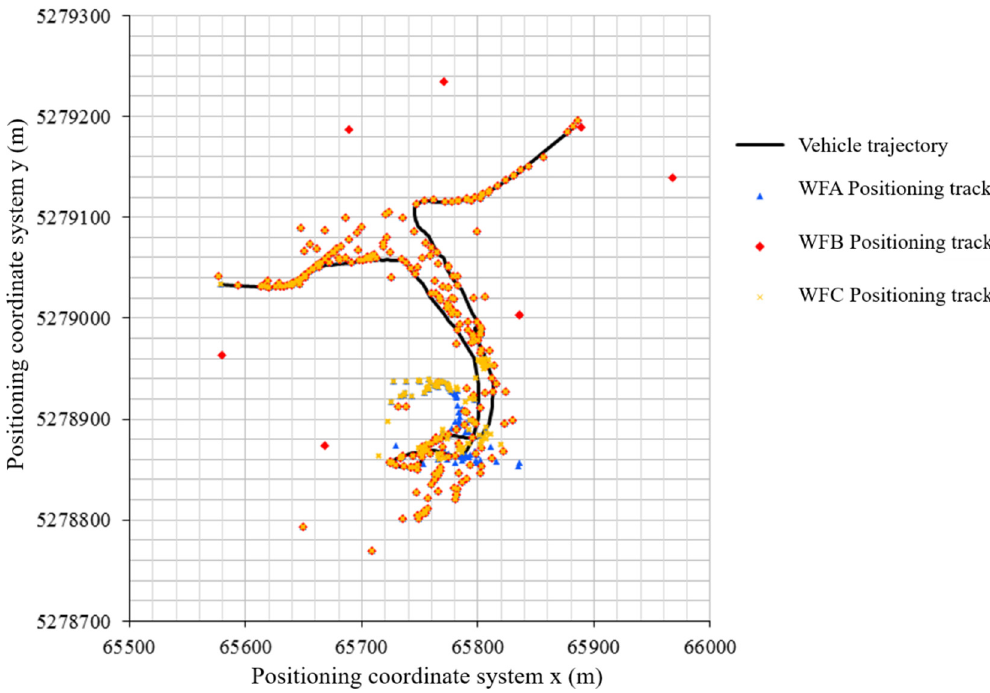
Figure 14. Fusion of fixing location coordinates.